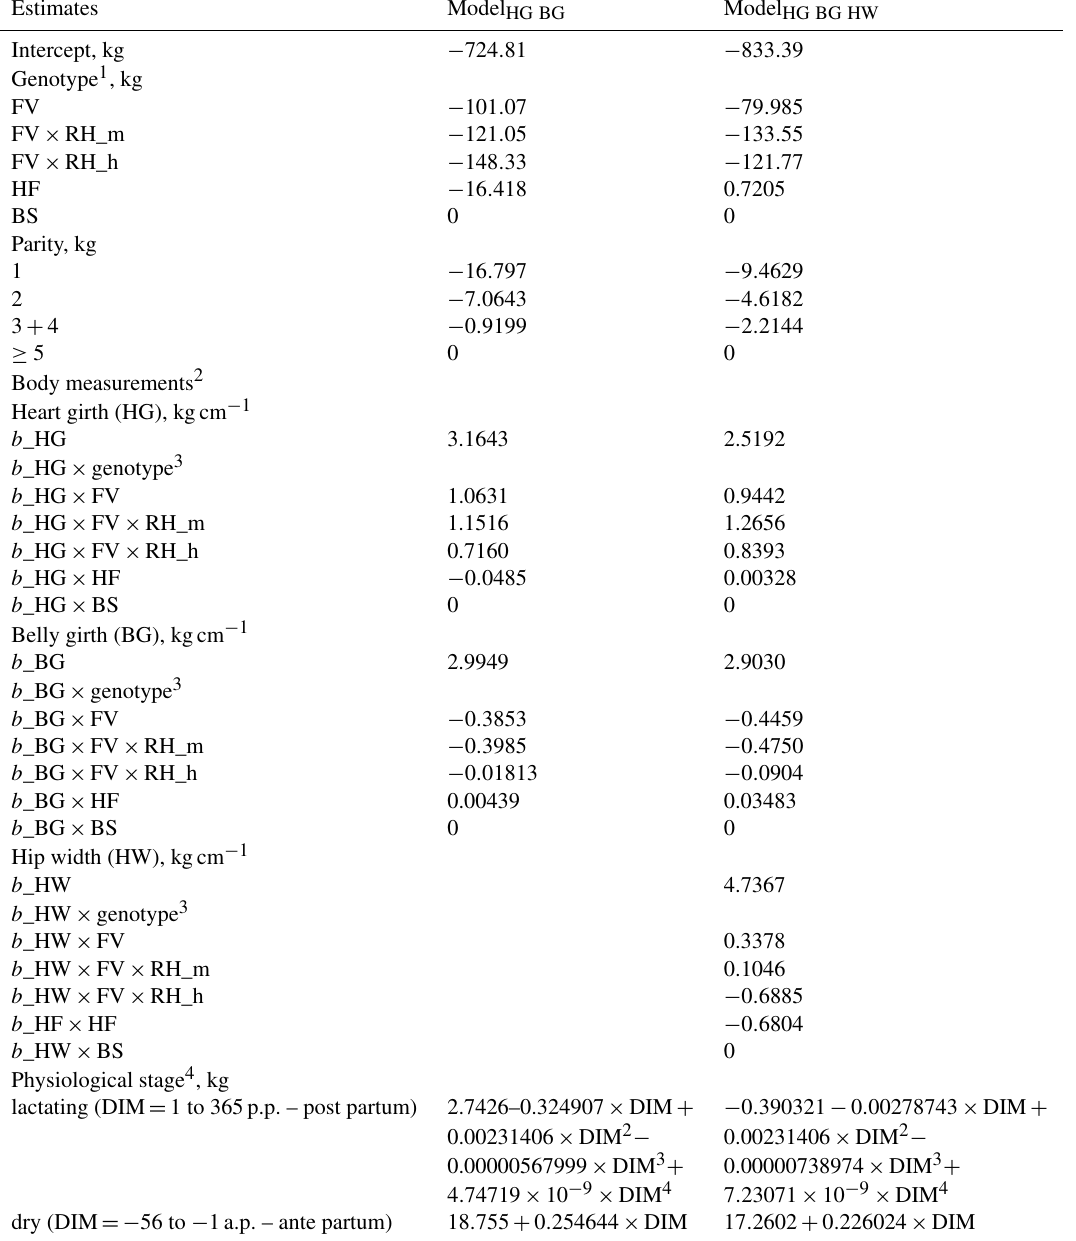
Table 4. Estimates for the intercept, the fixed effects genotype, parity, and the regression coefficients for the body measurements heart girth (HG), belly girth (BG), and hip width (HW) in the two body weight prediction models Model HG BG and Model HG BG HW